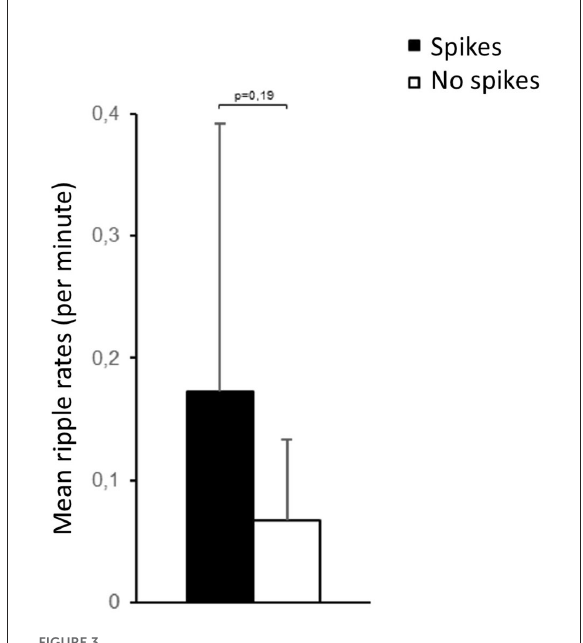
FIGURE3 No significant difference in HFO rates was seen for channels with and without interictal epileptic spikes.